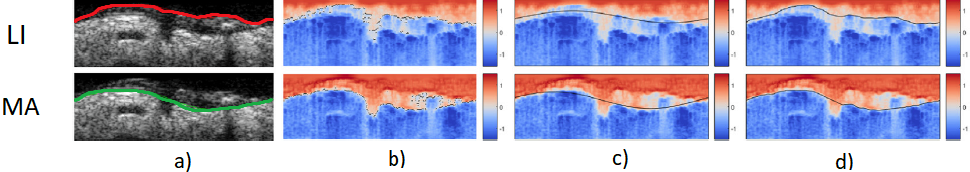
Figure 5. Main steps of LI and MA segmentation: ( a ) B-mode images,( b ) edge map, ( c ) contour segmentation, ( d ) final segmentation. LI and MA are marked in red and green, respectively